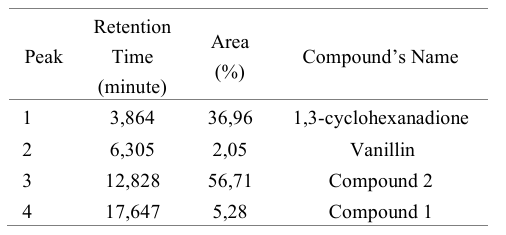
Table 1. GC-MS Analysis of synthesized compounds without catalyst